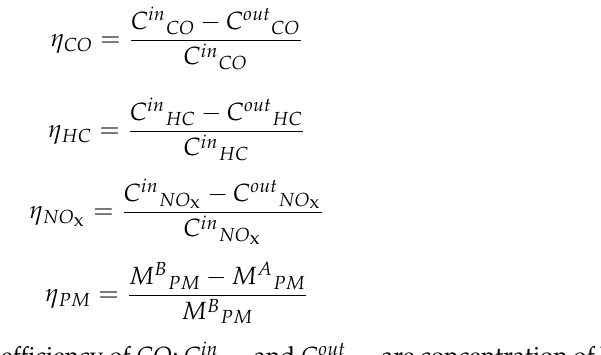
Figure 3. The supporting process of PM and catalyst samples.